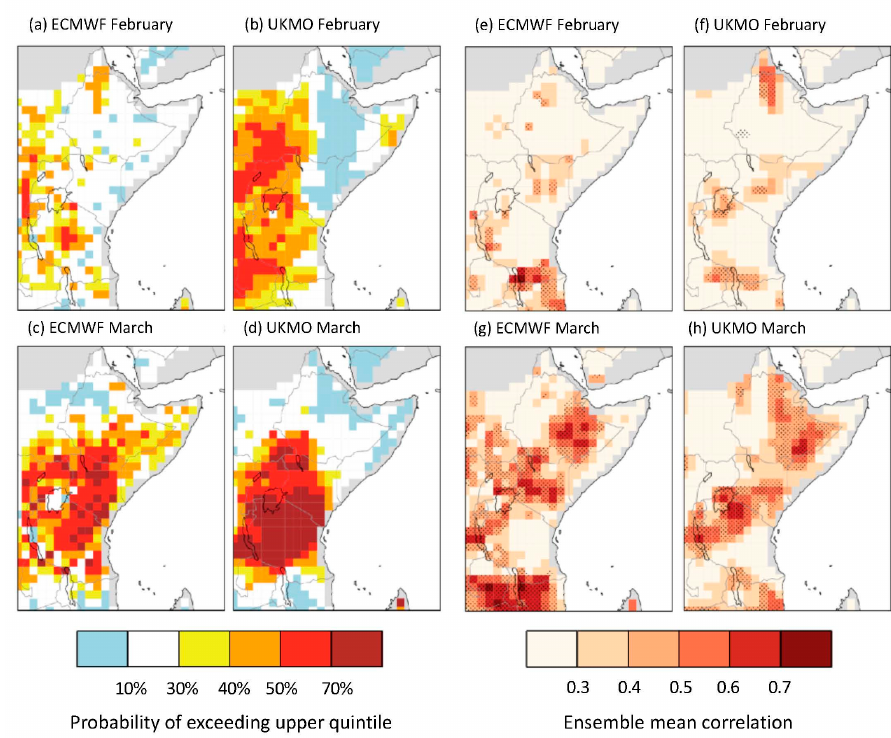
Figure 10. Comparison of seasonal rainfall forecasts for MAM 2018 at different lead times, and associated hindcast skill. ( a , c ) Probability of an upper quintile wet event issued in 1 February and 1 March, respectively from the European Centre For Medium-Range Weather Forecasts (ECMWF) seasonal forecast systems (SEAS5). ( b , d ) As ( a , c ) but for the United Kingdom Met Office (UKMO) Global Seasonal Prediction System 5 (GloSea5) system. ( e – h ) Ensemble mean anomaly correlation forecasts corresponding to the forecast models and lead times shown in ( a – d ), calculated over 1993–2018, compared to CHIRPS observed rainfall.